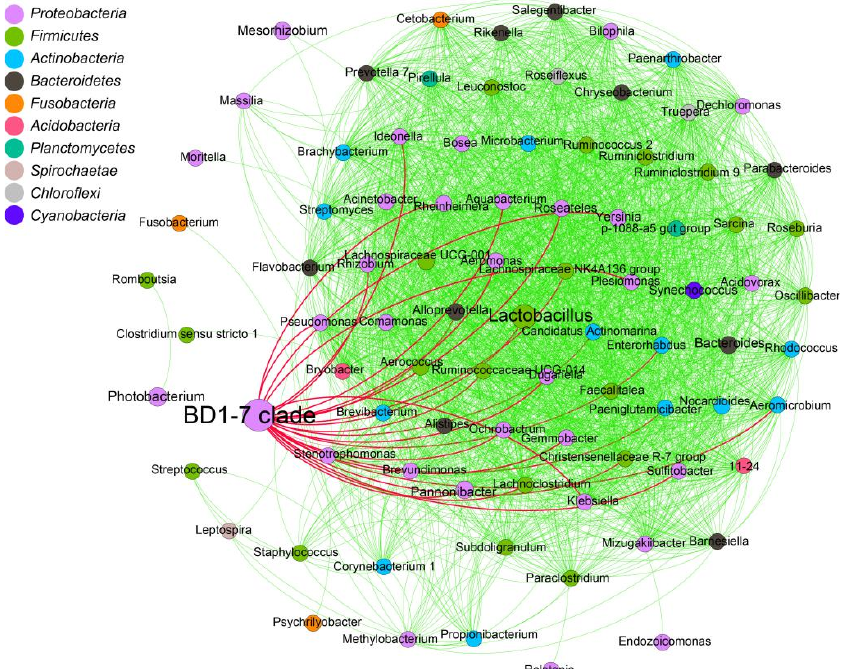
Figure 7. Correlation network analyses of the microbial communities of dwarf-form squid at the bacterial phyla level. The node size represents the abundance of each phylum. The green lines between phyla indicate a positive relationship, while the red lines indicate a negative relationship.